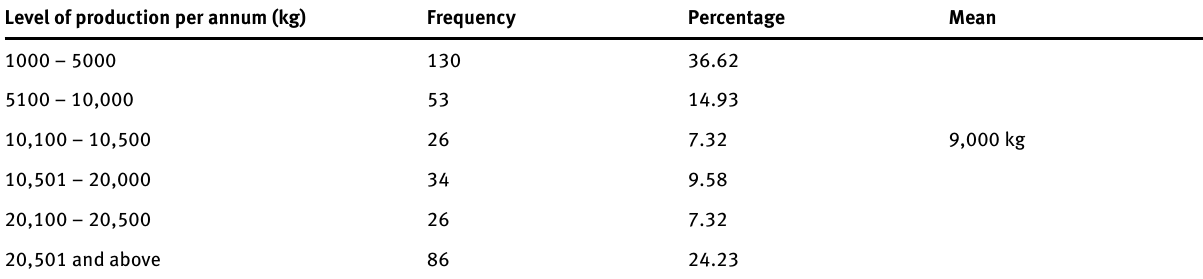
Table 3: Annual level of crop (cassava) production Level of production per annum